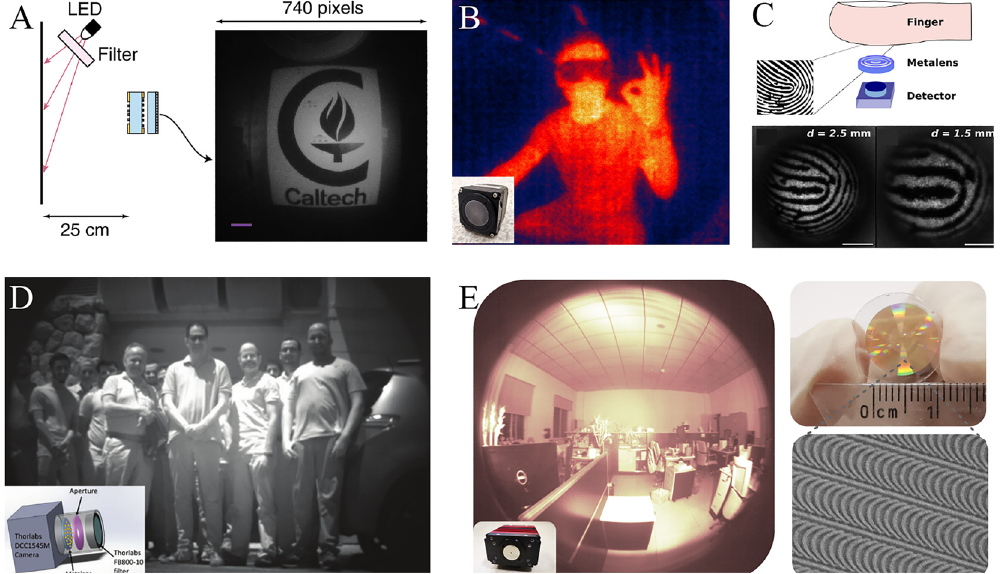
Figure 8: Applications of wide-angle metalenses for flat large-FOV imaging. (A)Imagingsetupandtheimagecapturedbytheminiaturemetasurfacedoubletcamera.Scalebar:100 μ m.Abandpass fi lter(850 ±